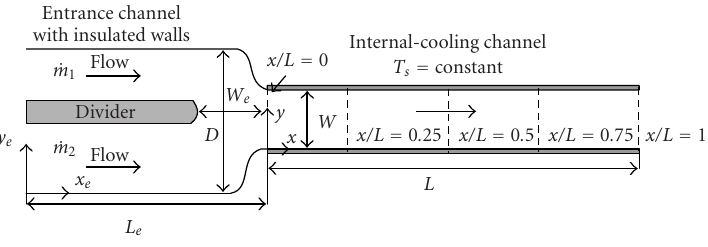
Figure 2: Physical model of the cooling channel considered with geometric and flow parameters